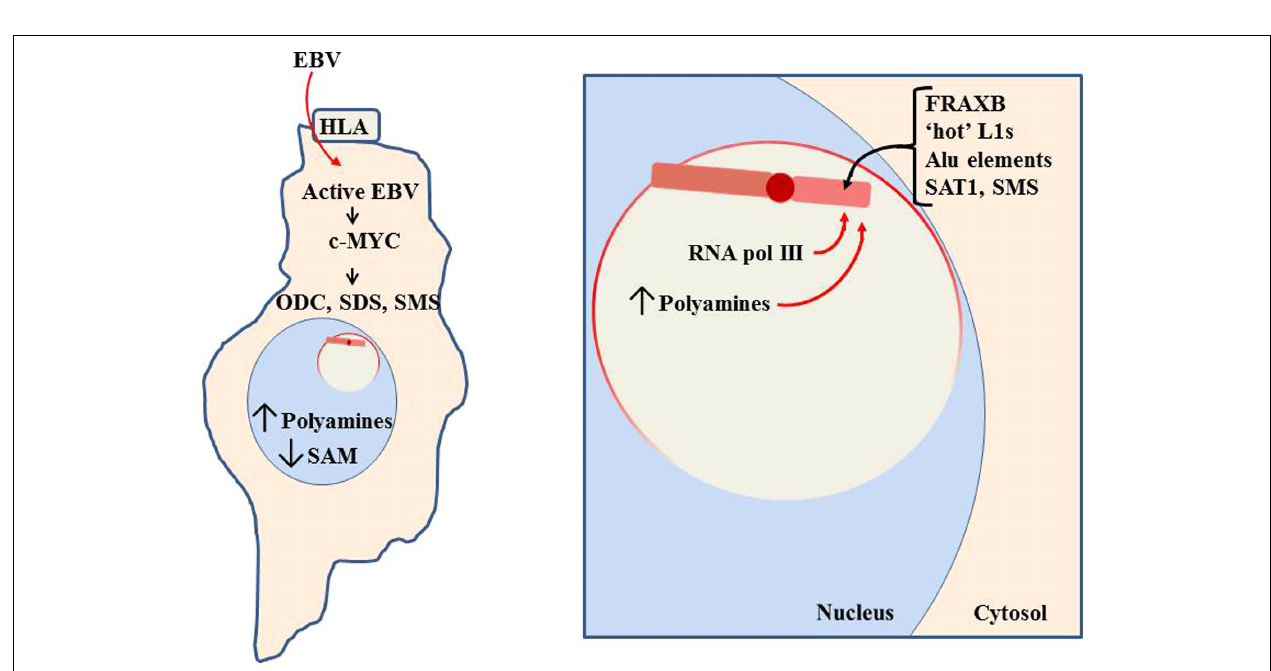
machinery in maintenance of the inactive state of the Xi.The Xi is seen in this close association 80–90% of S phase cells and approximately one-third of cells throughout interphase (Zhang etal., 2007).